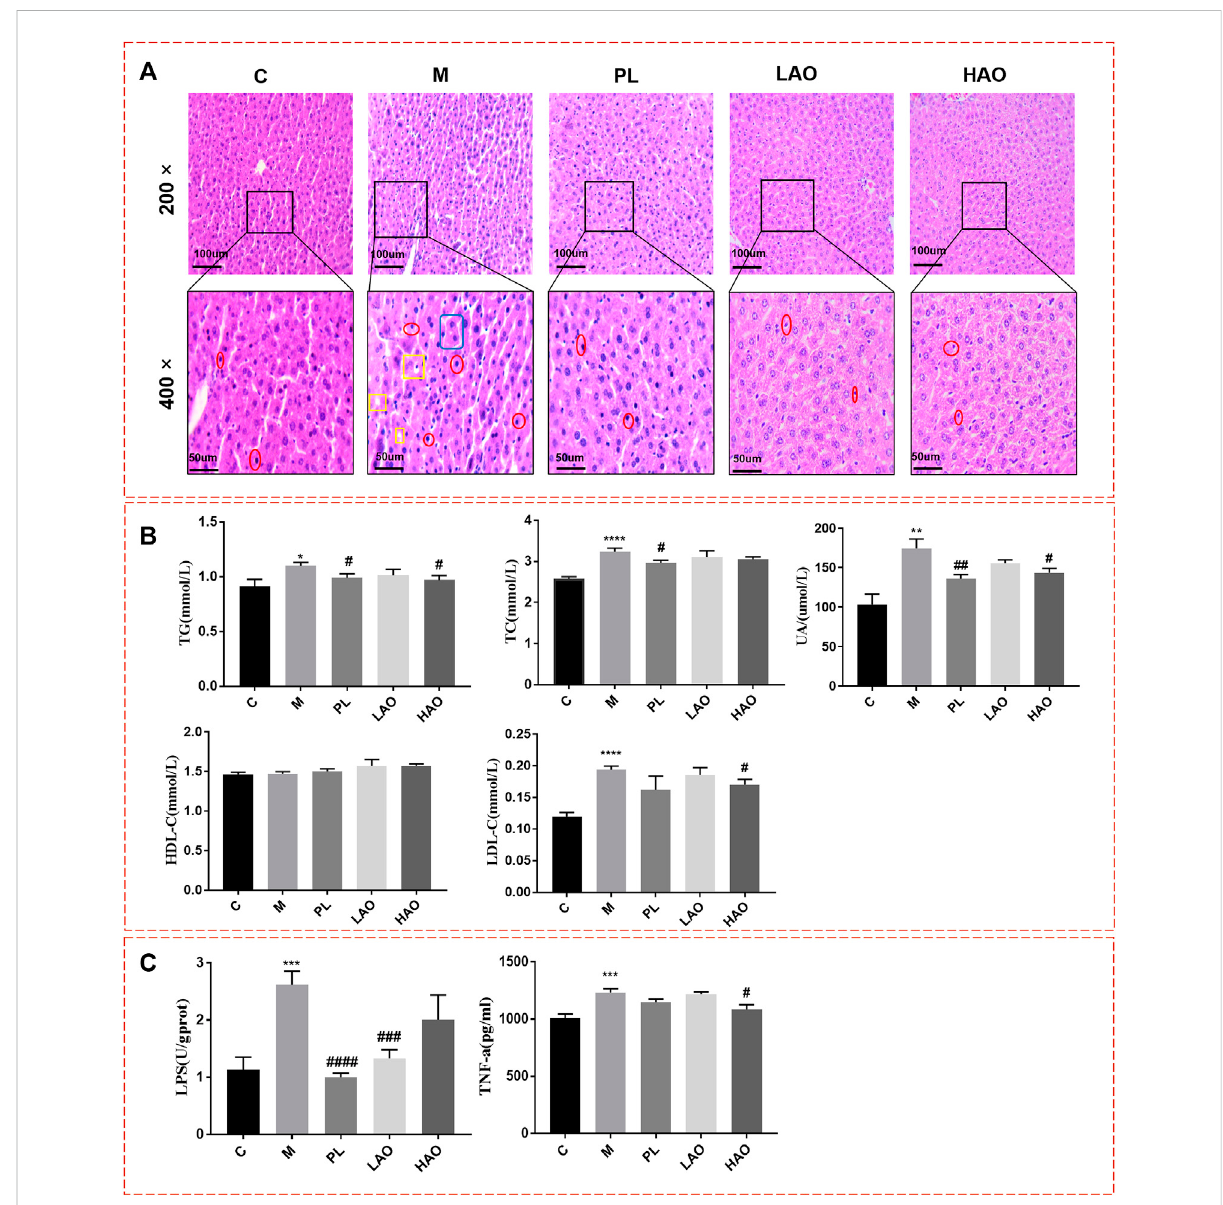
FIGURE 2 Mice liver tissue section and biochemical indexes. (A) H & E staining diagram of pathological section of liver of mice in each group with magni fi cation of 200× and 400× (where the position marked with red represents in fl ammatory cell in fi ltration; Yellow represents fatty degeneration and the generation of fat vacuoles; Blue represent hepatomegaly); (B) Statistical graph of serum biochemical indexes; (C) Statistical chart of liver biochemical indicators (* p < 0.05, ** p < 0.01, *** p < 0.001 and **** p < 0.001, vsC; # p < 0.05, ## p < 0.01, ### p < 0.001 and #### p < 0.0001, vs